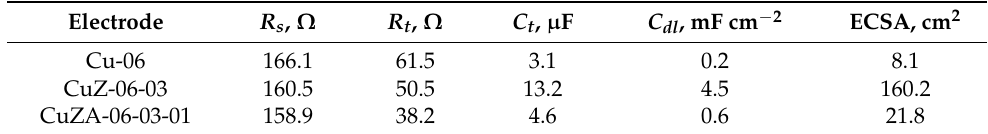
Table 4. Equivalent electrical circuit